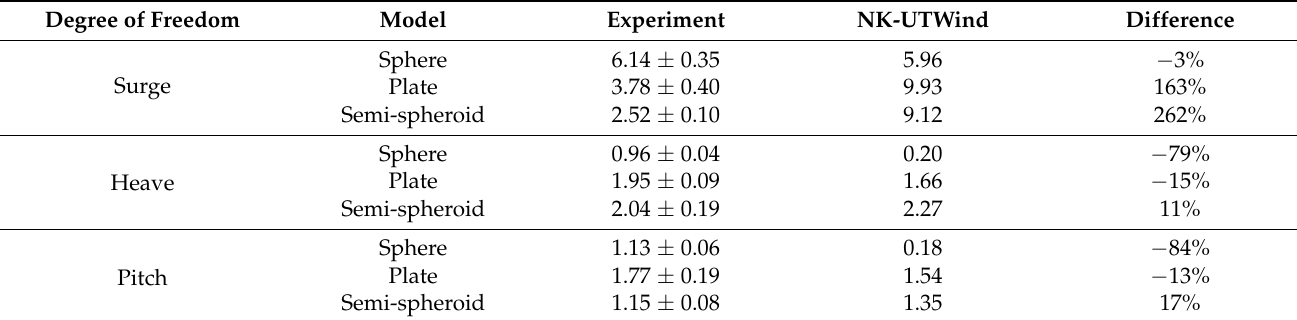
Table 6. Linear damping coefficients obtained from free decay tests ζ [%].